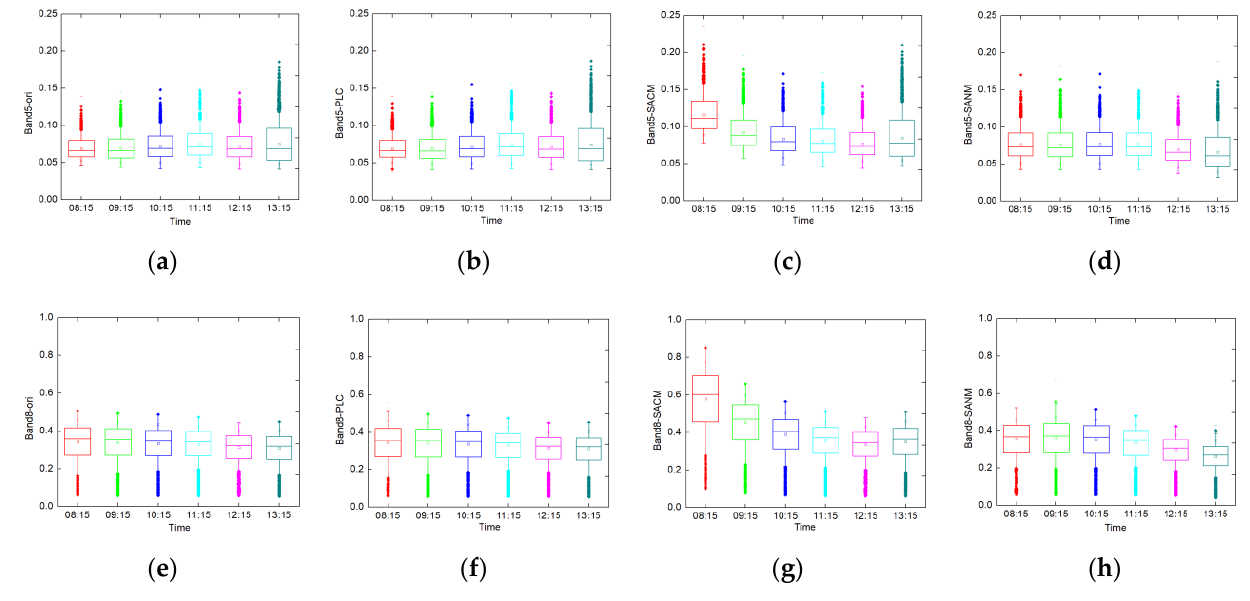
Figure 6. Box plots of ( a ) the original Rayleigh-corrected GOCI band 5 reflectance; ( b ) the GOCI band 5 reflectance after PLC correction (Band5-PLC); ( c ) the GOCI band 5 reflectance after ASCM correction with Band5-ori as 𝜌 t (Band5-SACM); ( d ) the GOCI band 5 reflectance after SANM normalization (Band5-SANM) in each imaging time for the morning time window and the double-peak time window; ( e – h ) same as ( a – d ) correspondingly except using band 8 reflectance.